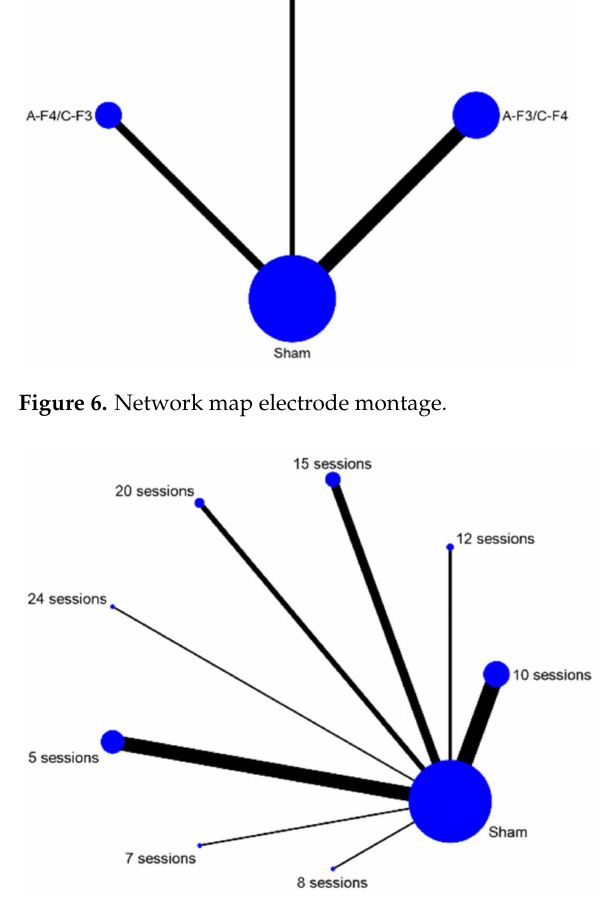
Figure 7. Network map number of sessions.